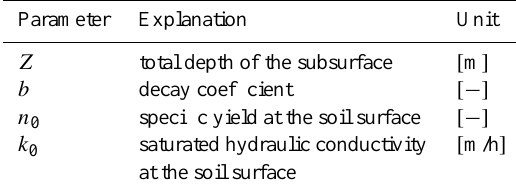
Table 1. Calibration parameter. Parameter